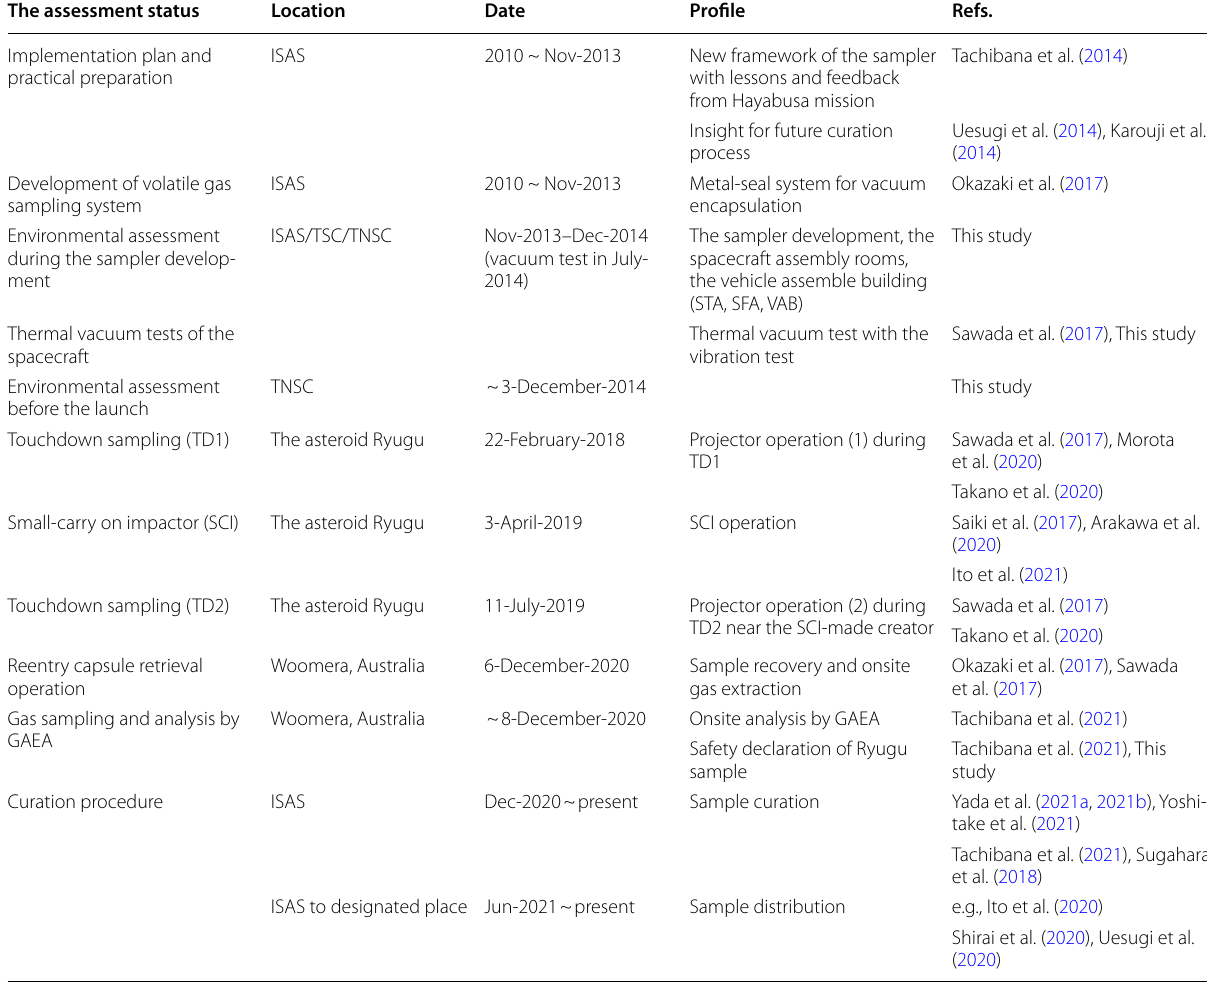
Table 1 Overview and compilation of the entire sample processes from implementation to engineering development and assessment for quality control for the safety declaration of the Ryugu